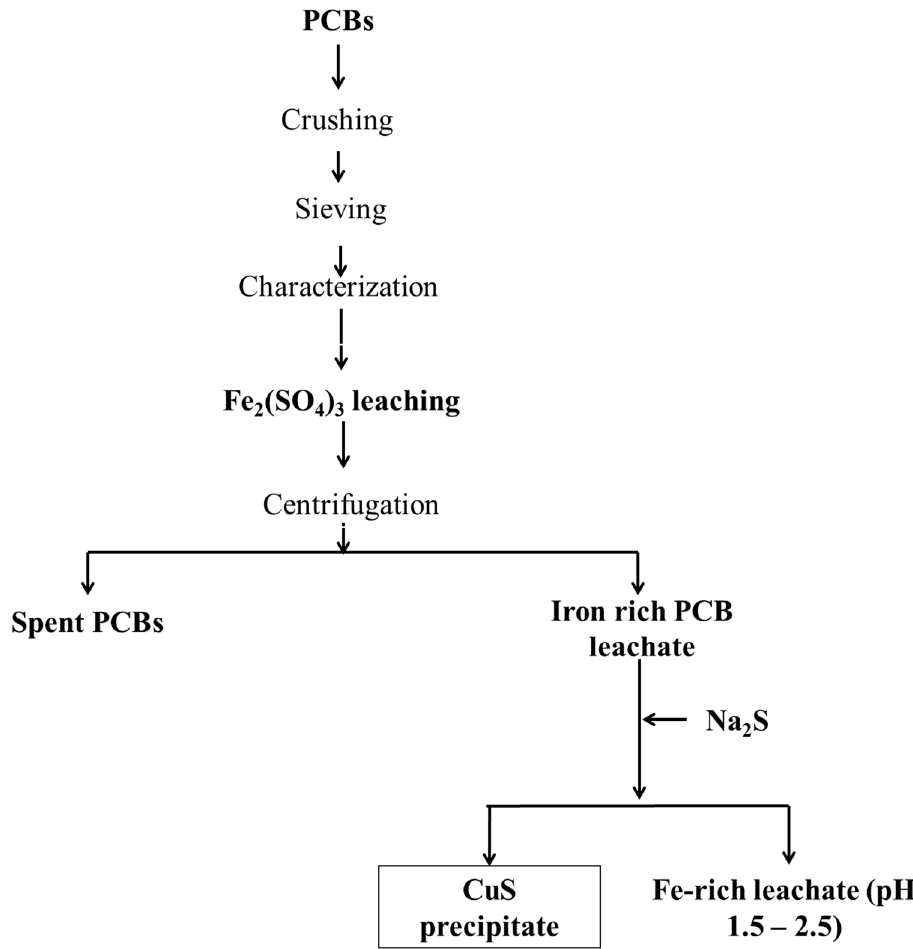
Figure 9. Hydrometallurgical flow chart for the selective recovery of Cu from PCBs.